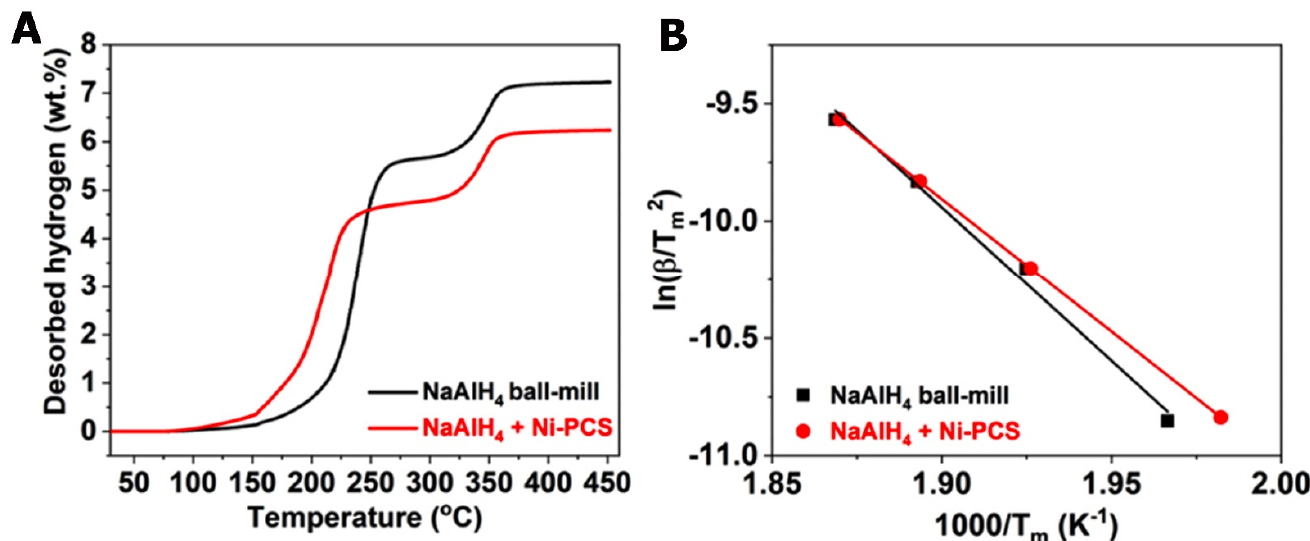
Figure 17. ( A ) Hydrogen desorption capacity curves of ball milled Mg(AlH 4 ) 2 and Mg(AlH 4 ) 2 with Ni-PCS. ( B ) Kissinger’s plots for dehydrogenation of ball milled Mg(AlH 4 ) 2 (box solid, Ea = 118 kJ·mol − 1 ) and Mg(AlH 4 ) 2 with Ni-PCS (red-colored circle solid, Ea = 103 kJ·mol − 1 ). Figure was reprinted with permission from ref. [125].